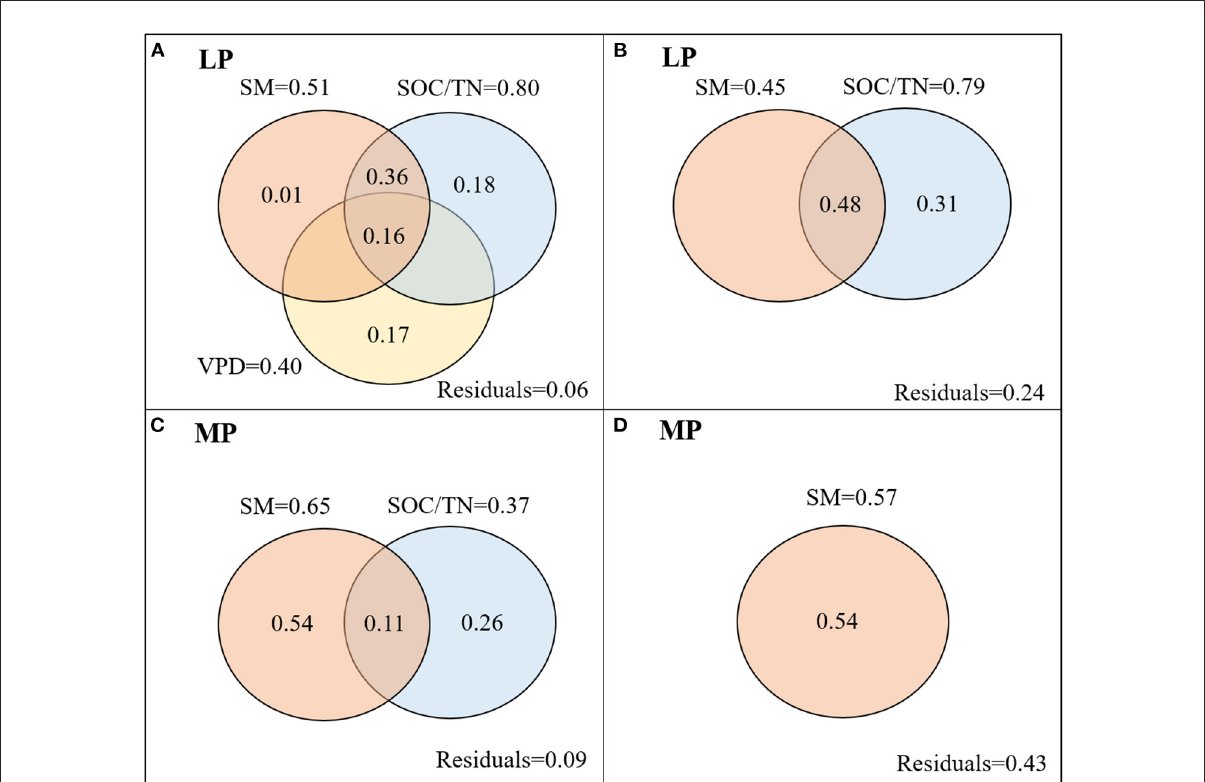
FIGURE5 Variation partitioning (R 2 ) of environmental factors in mean (A,C) and coefficient of variation (CV) (B,D) of iWUE of co-occuring species in LP (A,B) and MP (C,D) . LP, Loess Pleateau; MP, Inner Mongolia Plateau; SM, soil moisture; VPD, vapor pressure deficit, VPD; SOC/TN, the ratio of soil organic carbon content to soil total nitrogen